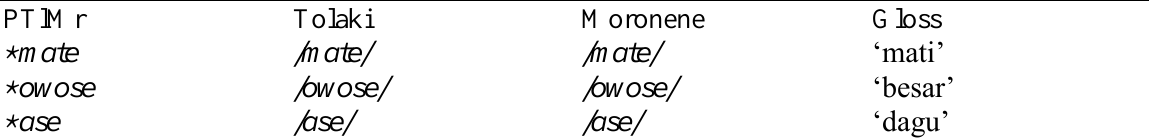
Table 13. The Final Word Position